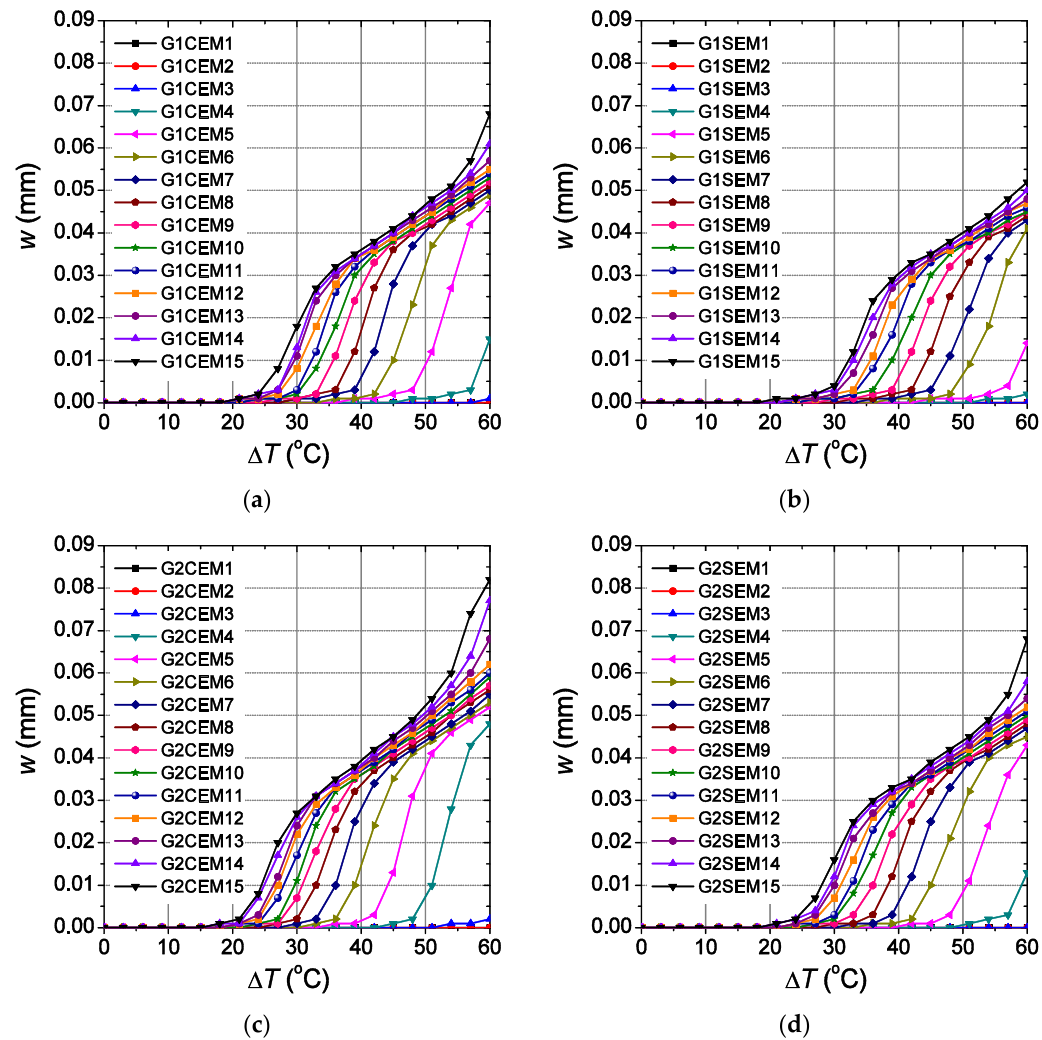
Figure 9. Influence of the elastic modulus in the crack opening evolution in Z3 for sleepers designed with glass-fibre reinforced polyamide, different types of aggregate and dowel geometries: ( a ) C and G1; ( b ) S and G1; ( c ) C and G2; ( d ) S and G2.